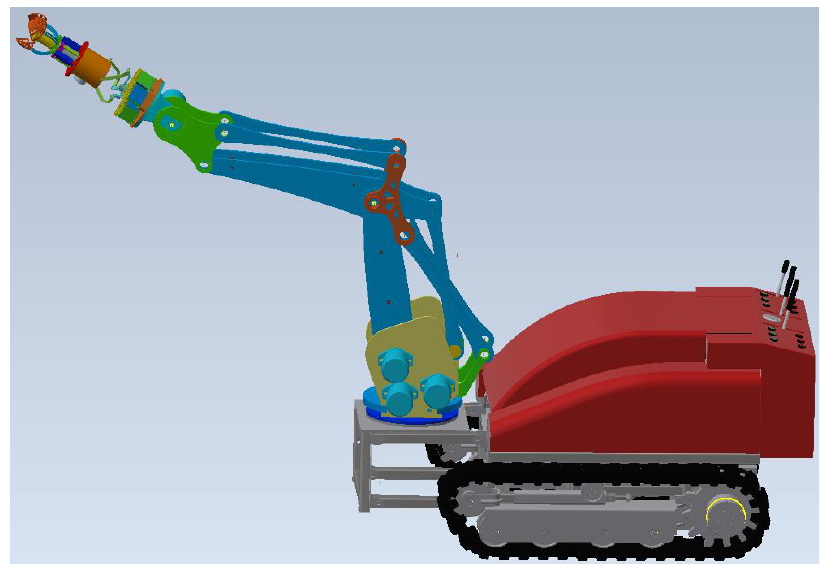
Figure 2. Three-dimensional model of the pollen-picking robot.